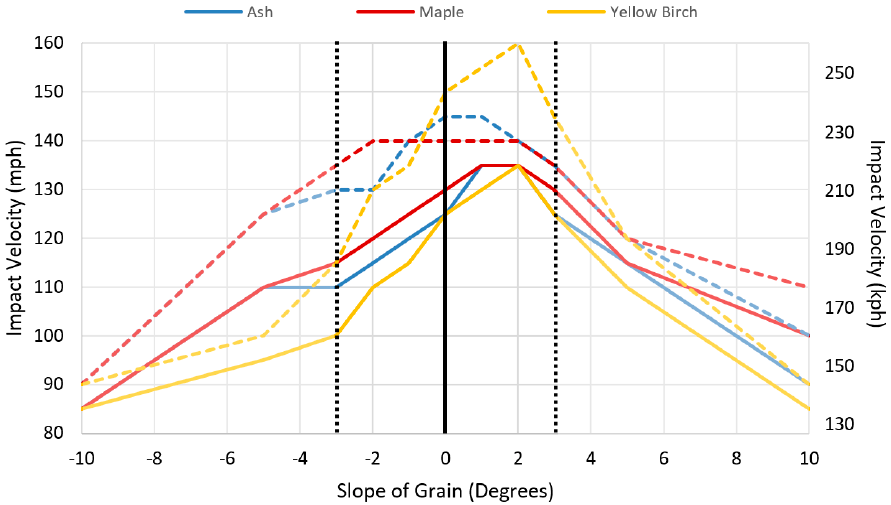
Figure 13. Single-piece (solid lines) / multi-piece failure (dashed lines) threshold for 14 in. (35.6 cm) impact models.